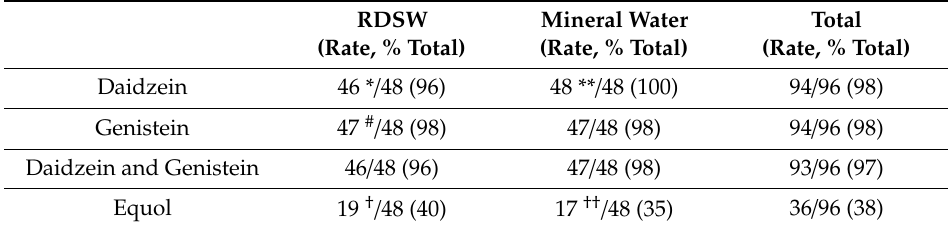
Table 3. Detection rates of urinary isoflavones in the two groups.